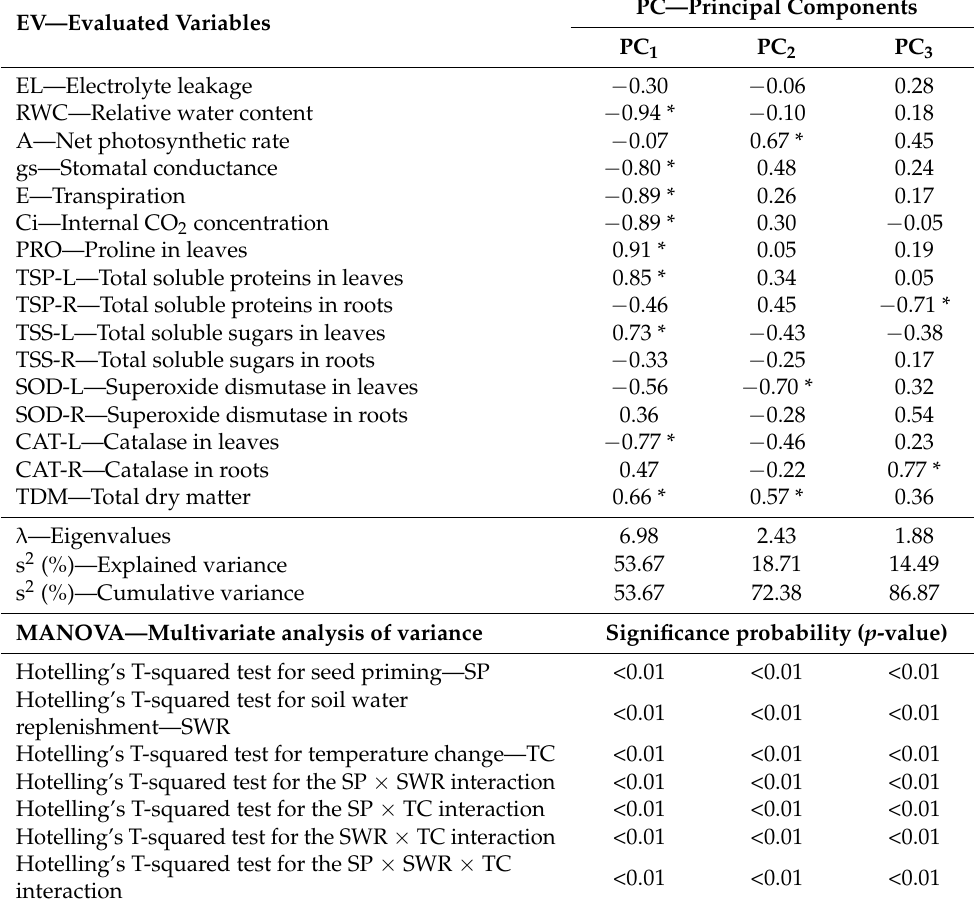
Table 1. Correlation between the original variables and principal components, eigenvalues, explained and cumulative variance, and probability of significance of the hypothesis test in the interaction between the first three principal components (PCs 1, 2, and 3) and seed priming, soil water replenish- ment levels, and temperature change in Moringa oleifera